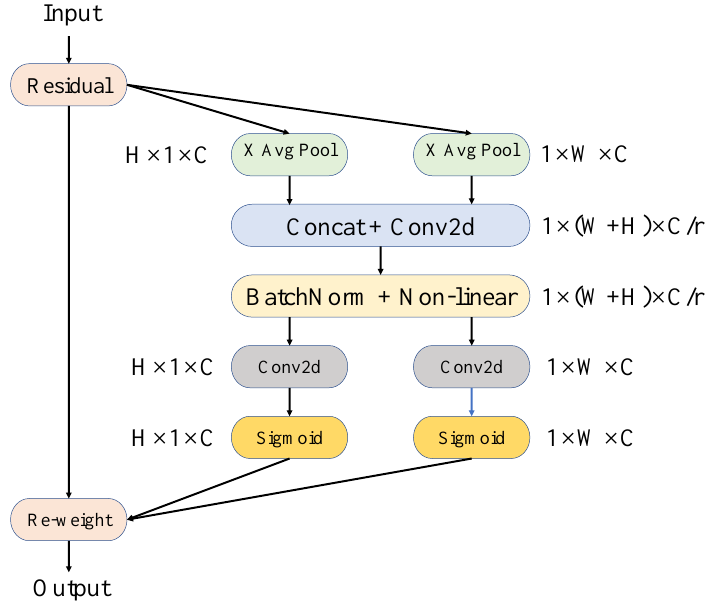
Figure 4. The conventional Coordinated Attention